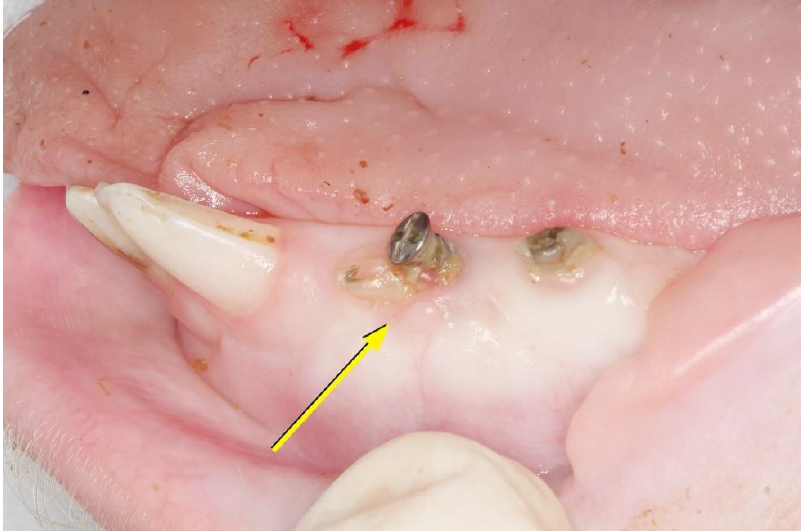
Figure 5. Graft condition 90 days after surgical placement. The yellow arrows indicate the location of